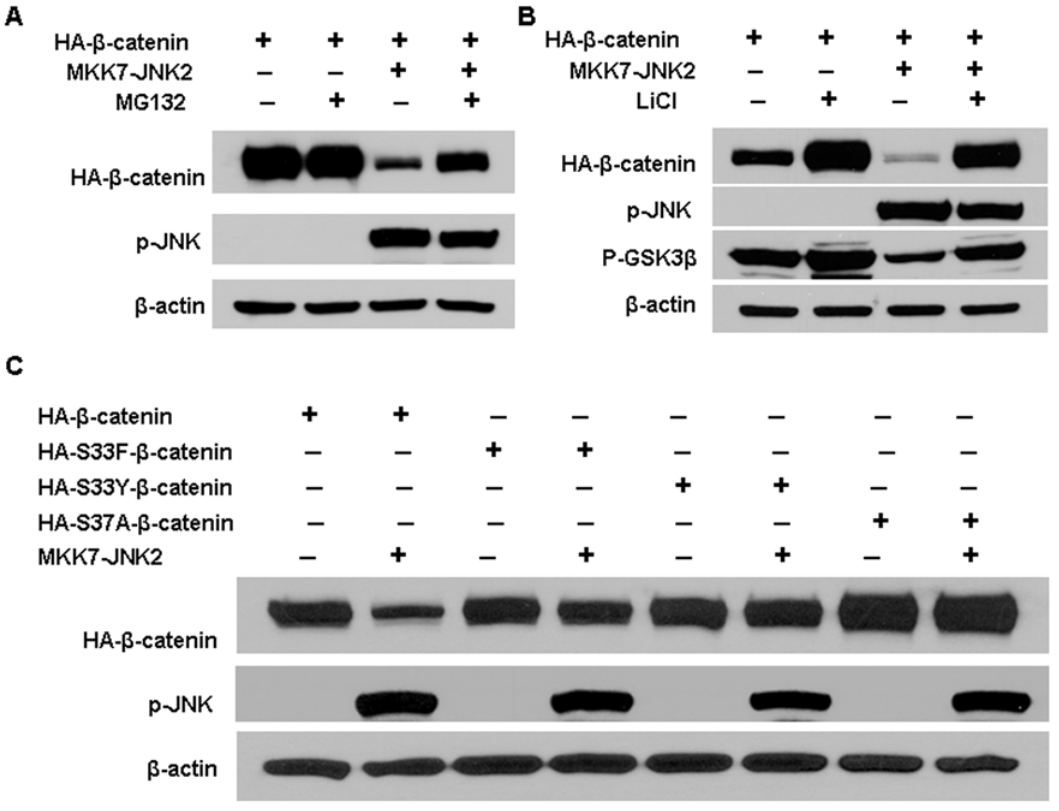
Figure 3. Active JNK2-mediated b -catenin degradation occurred through the proteasome system and GSK3 b . ( A ) HEK293T cells were co-transfected with pcDNA3-HA- b -catenin and pcDNA3-Flag-MKK7-JNK2 (lane 3 and 4) or empty vector (lane 1 and 2). Forty-four hours after transfection, 25 m M MG132 was added to the indicated samples (lane 2 and 4). Four hours later cells were harvested for immunoblotting analysis to detect the expression of HA- b -catenin and p-JNK. ( B ) Blocking GSK3 b activity by LiCl reduced b -catenin expression inhibition by activated JNK2. pcDNA3-HA- b -catenin was transfected into HEK293T cells along with pcDNA3-Flag-MKK7-JNK2 (lane 3 and 4) or empty vector (lane 1 and 2). Thirty- six hours after transfection, half of the cultures were treated overnight with 30 mM LiCl (lane 2 and 4) and then harvested for immunoblotting analysis to detect the expression of HA- b -catenin, phospho-Ser-9 GSK3 b , and p-JNK. ( C ) Mutant b -catenin was resistant to activated JNK2 induced degradation. Wild-type b -catenin (HA- b -catenin) (lanes 1 and 2) or various b -catenin mutants (HA-S33F b -catenin, lanes 3 and 4; HA-S33Y b -catenin, lanes 5 and 6; HA-S37A b -catenin, lanes 7 and 8) were transfected into HEK293T cells along with pcDNA3-Flag-MKK7-JNK2 (lane 2,4,6,8) or empty vector (lanes 1,3,5,7). 48 hours after transfection, cells were harvested for immunoblotting analysis to determine the protein levels of HA- b -catenin. b - actin served as loading control.